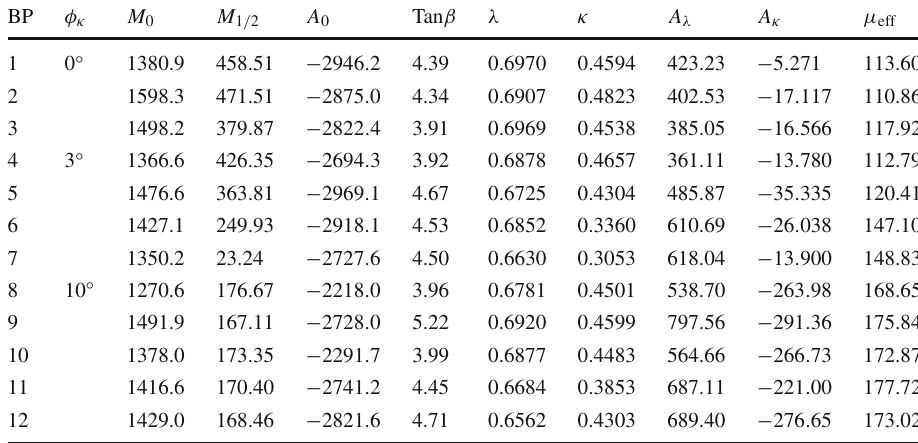
Table 2 Values of the input parameters for all the selected BPs. All dimensionful parameters are in units of GeV